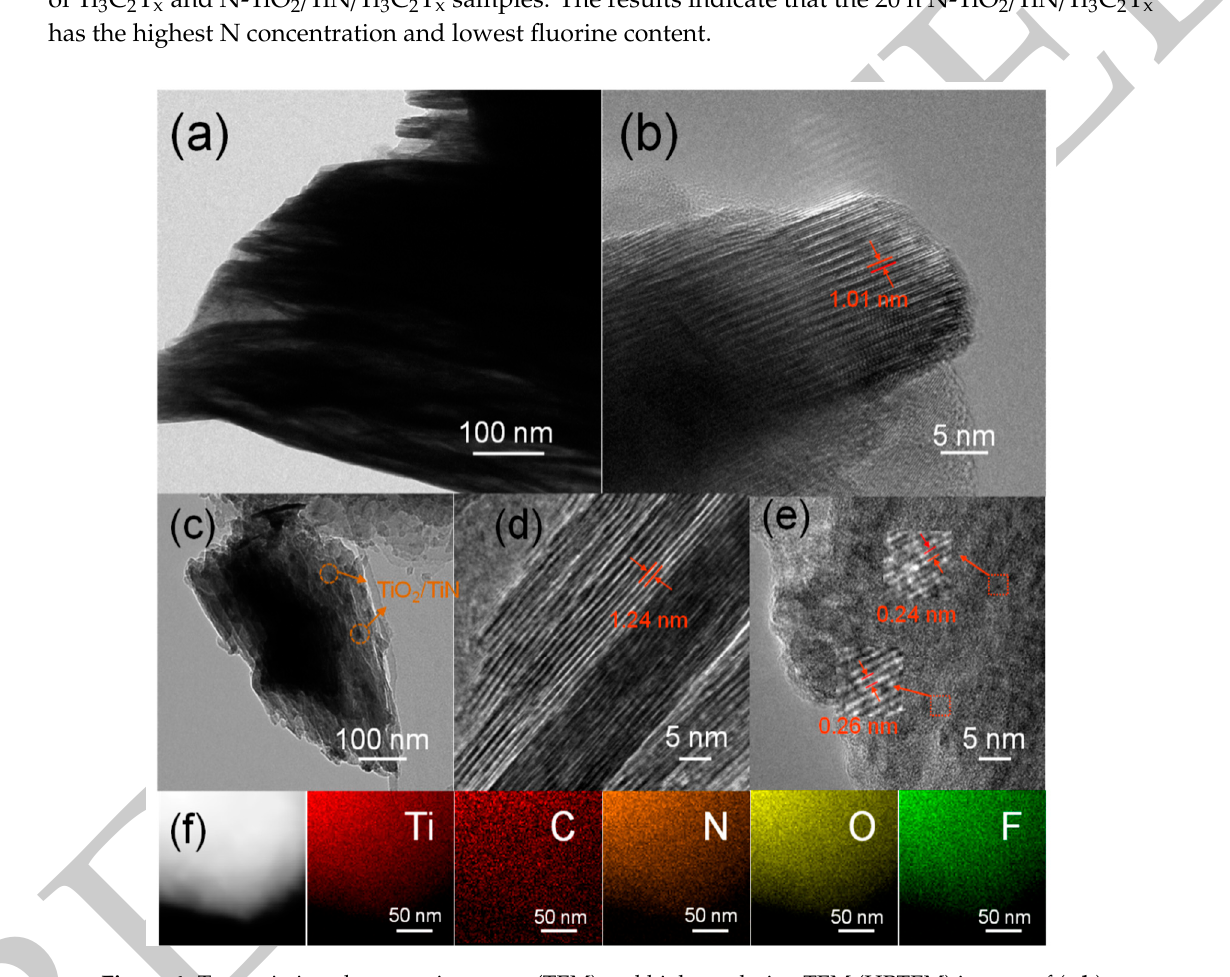
Figure 4. Transmission electron microscopy (TEM) and high-resolution TEM (HRTEM) images of ( a , b ) Ti 3 C 2 T x and ( c – e ) 20 h N-TiO 2 /TiN/Ti 3 C 2 T x . ( f ) EDS element mapping of 20 h N-TiO 2 /TiN/Ti 3 C 2 T x . Table 1. The atomic concentration (at %) of elements from Ti 3 C 2 T x and N-TiO 2 / TiN / Ti 3 C 2 T x . Materials